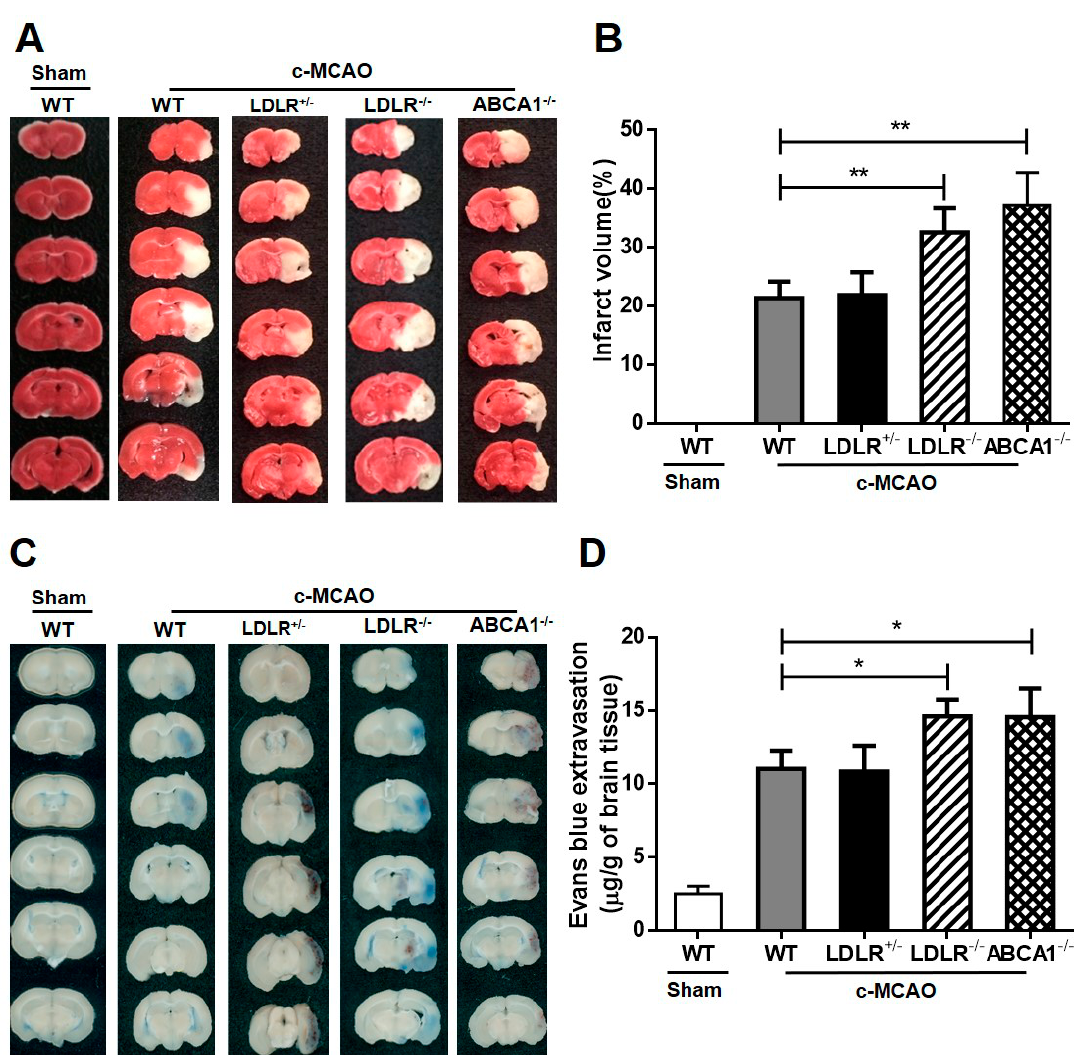
Figure 4. Effects of different types of dyslipidemia on infarct volume and blood–brain barrier (BBB) destruction. ( A ) Representative images of six coronal brain slices showing the cerebral infarct with TTC staining after c-MCAO surgery. ( B ) The infarct volumes of each group were quantified ( n = 5 / group). ( C ) Representative images of the EB-stained brain sections; ( D ) Quantification of the Evan’s blue extravasation ( n = 5 / group); Data are expressed as mean ± SD. * p < 0.05; ** p < 0.01 versus sham group.